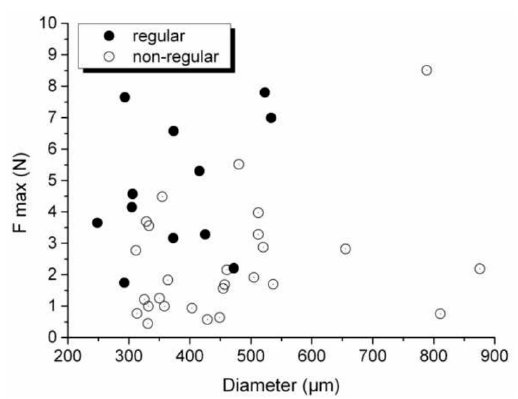
Figure 6. Values of maximum load ( Fmax ) (N) recorded by pull-out test on samples made of untreated bamboo fibers embedded in a PLA matrix. The values are plotted as a function of the fiber equivalent diameter ( μ m) for both regular and non-regular samples.